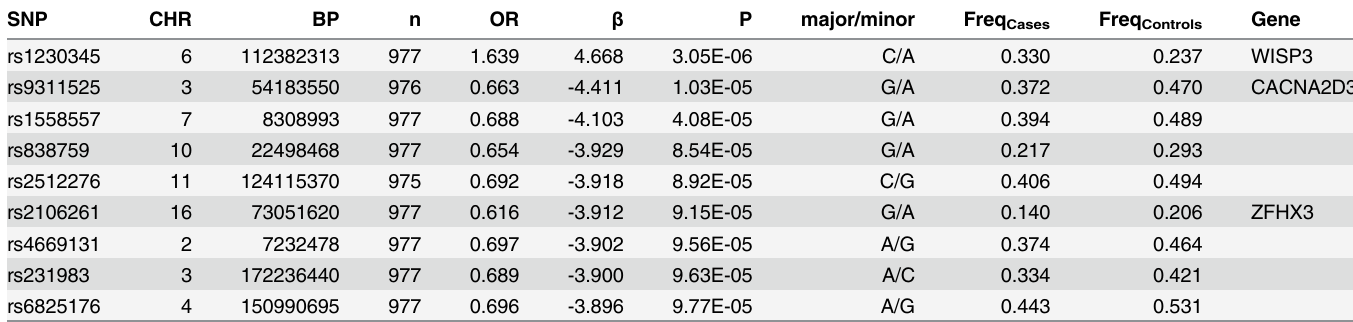
Table 1. Autosomal SNPs that had a p-value below 10 − 4 after logistic regression using the first 3 principal